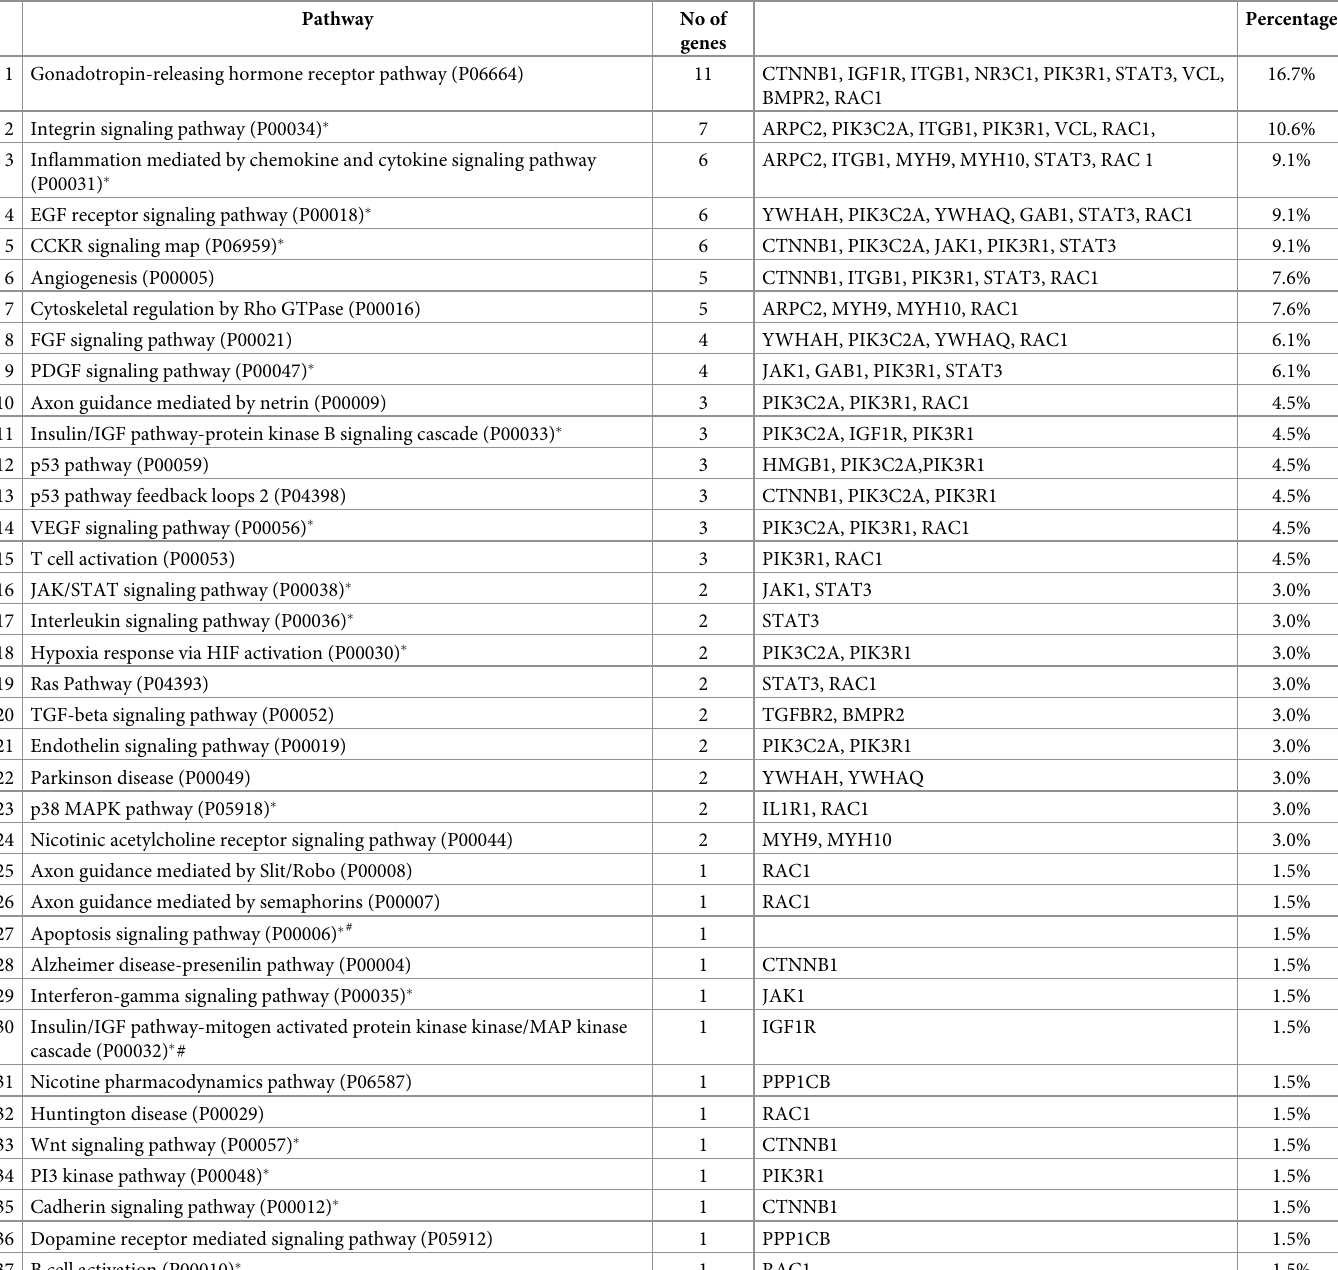
Table 4. Functional classification of the upregulated genes according to the pathways they influence and control.